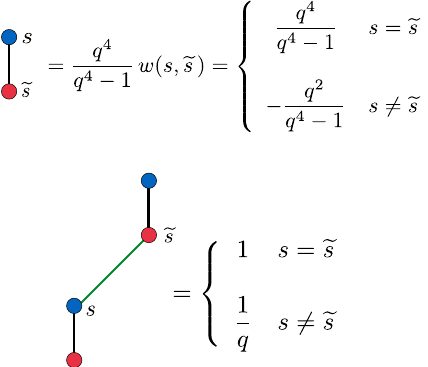
FIG. 14. Weights due to the interaction between adjacent Ising variables arising from the same unitary (top diagram) and from unitaries at adjacent time steps (bottom diagram). After inte- grating out the “ bra ” Ising variable s 0 , we obtain the weights shown in Fig. 15.